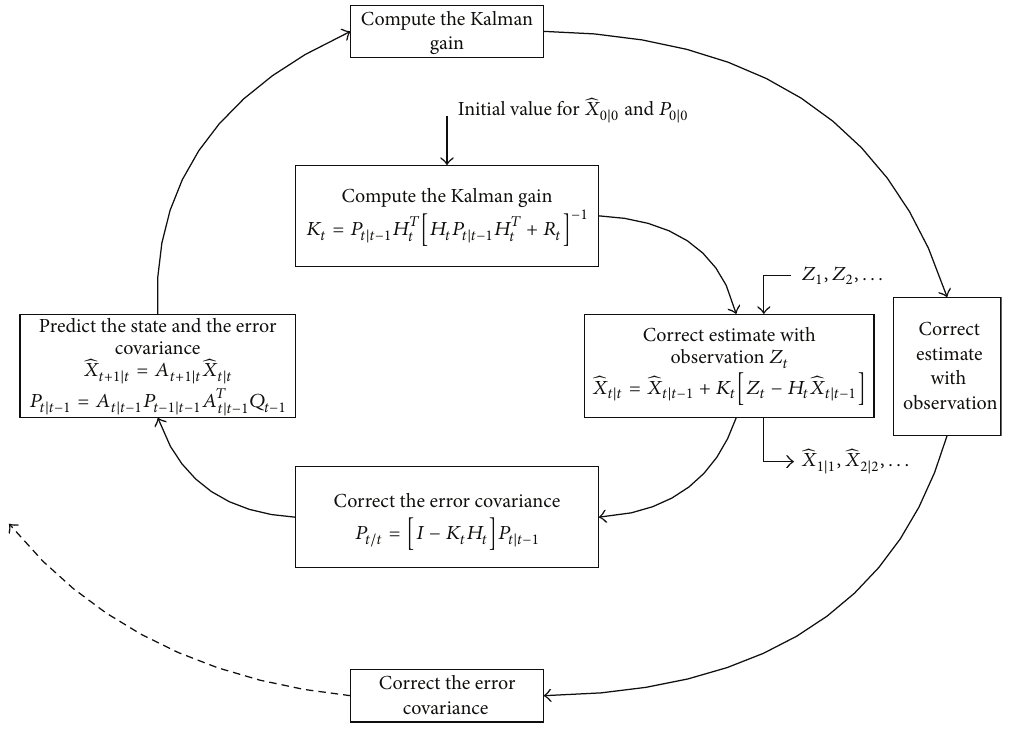
Figure 1: A complete picture of the operation of the Kalman